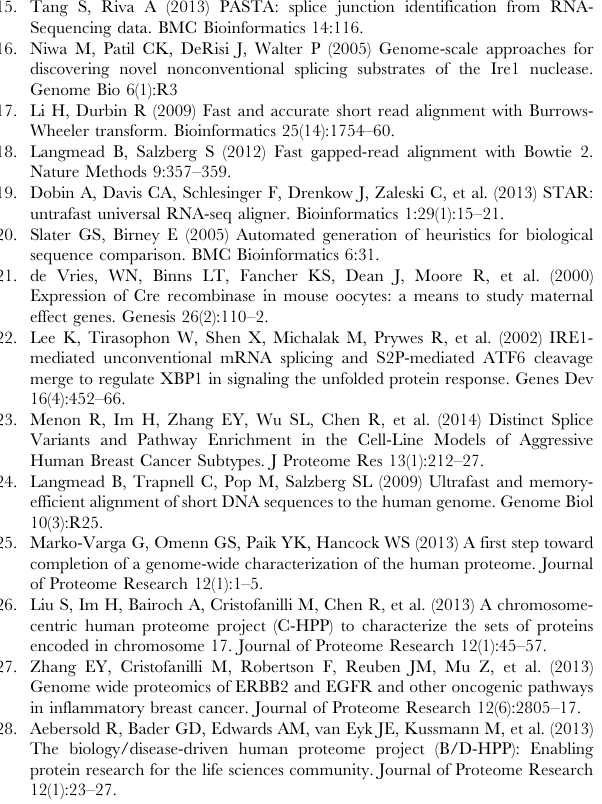
Table S2 A list of genes with novel spliced regions detected by RSW and their read supporting information. Table S3 A list of reads supporting Xbp1 26 bp spliced region identified by BWA.